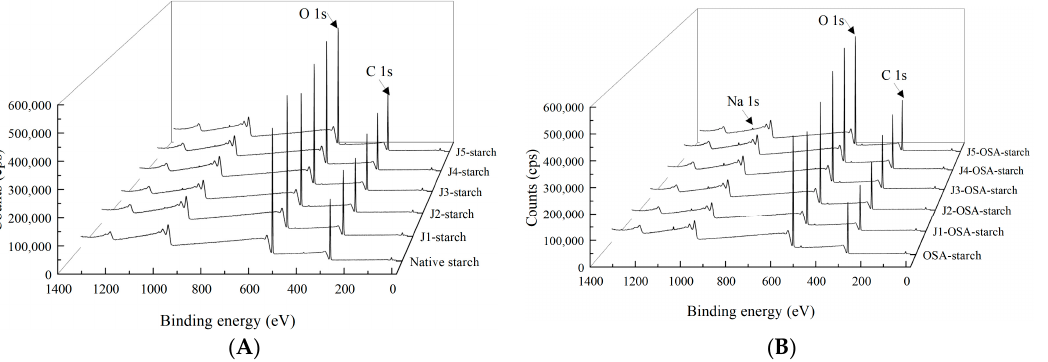
Figure 4. XPS analysis of J-starch and J-OSA-starch: ( A ), XPS patterns of J-starch; ( B ), XPS patterns of J-OSA-starch. Table 2. Surface elemental composition of J-starch and J-OSA-starch.